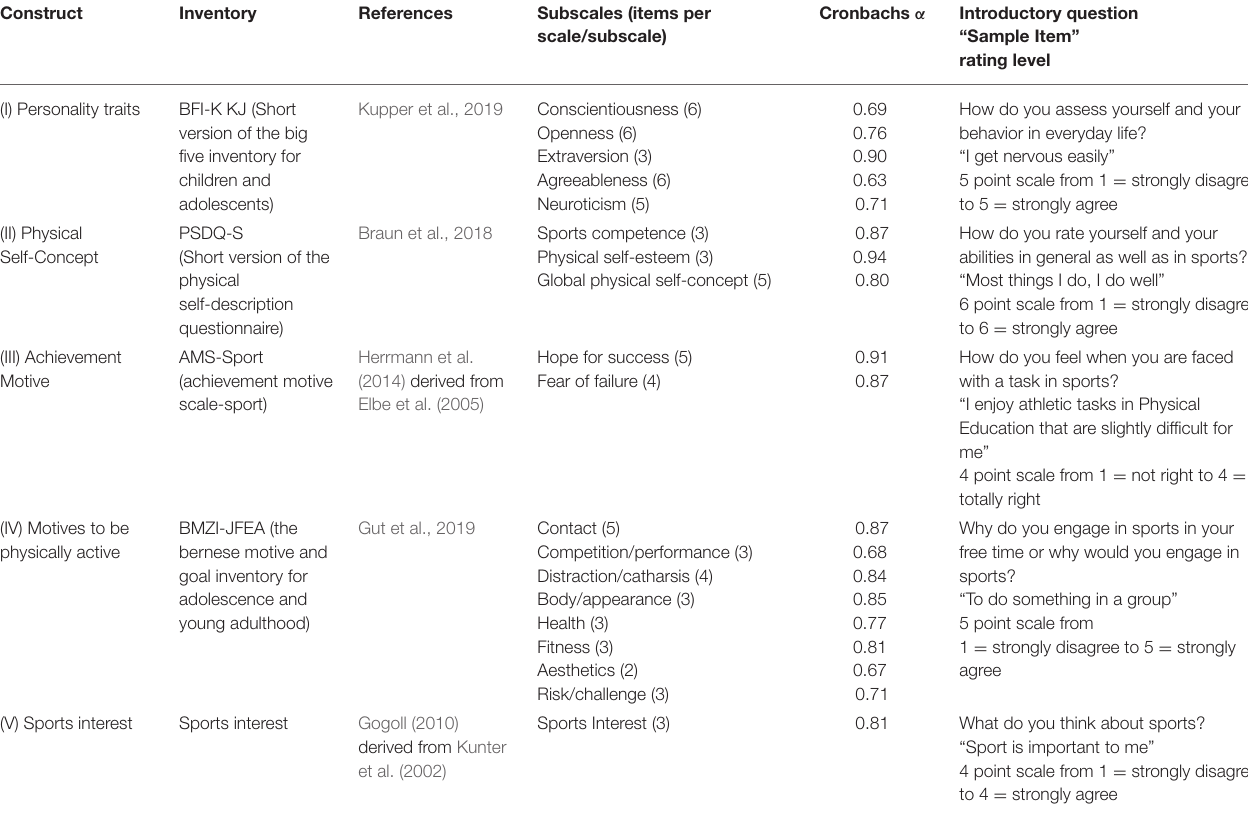
TABLE 1 | Applied scales to measure students’ characteristics in physical eduation